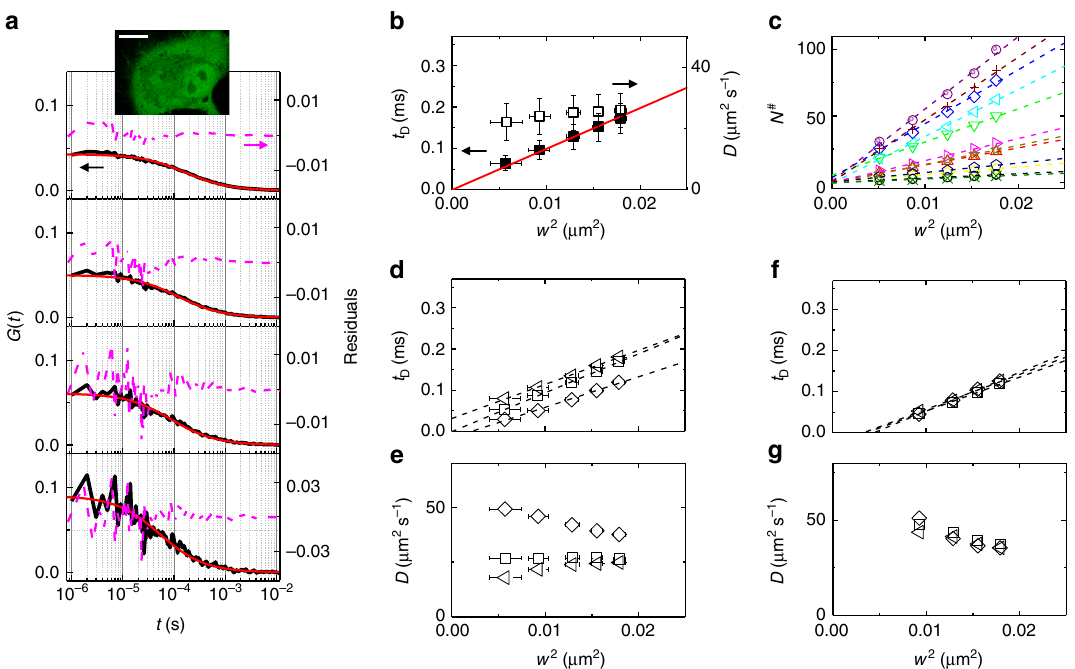
Fig. 3 SPLIT-FLCS of EGFP in the cytoplasm of live cells. a Representative fi ltered ACFs of EGFP in the cytoplasm of a HeLa cell at a STED power of 50 mW for different values of the parameter r 1 . Solid lines are a fi t of the data to Eq. (15). Residuals are shown on the right axis. The image of a cell is shown in the inset (scale bar 10 μ m). b Transit time t D ( solid squares ) and apparent diffusion coef fi cient D ( open squares ) for different spatial scales, obtained as the average of single-point measurements in the cytoplasm of n = 12 different HeLa cells (mean ± s.d.). The solid line is a fi t to Eq. (14) ( D = 25 μ m 2 s − 1 ). c Corrected value of the number of molecules N # vs. w 2 , for all the measured cells. The dashed lines are linear fi ts to the data. The slope varies from cell to cell according to differences in EGFP expression level. d Transit time t D and e apparent diffusion coef fi cient D at different spatial scales for three different cells. f Transit time t D and g apparent diffusion coef fi cient D as measured on the very same spot by three short ( t acq = 20 s) consecutive